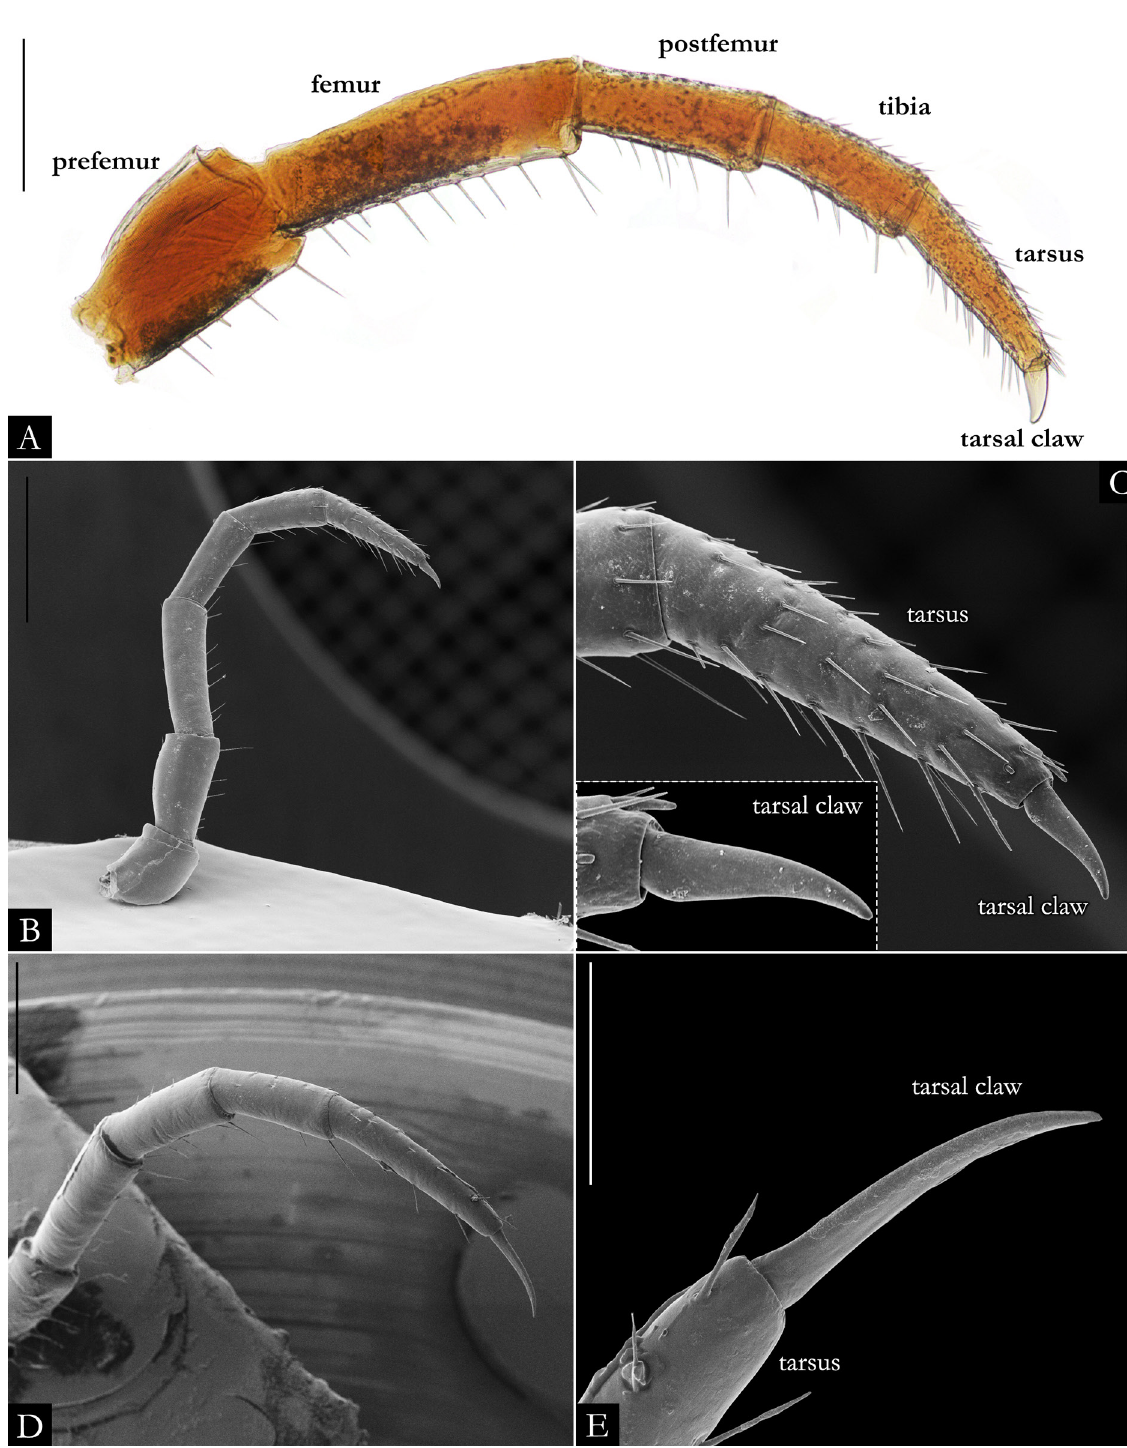
Fig. 29. Microscope and SEM images of midbody legs. A . Pseudonannolene microzoporus Mauriès, 1987 (IBSP 3497). B–C . P. robsoni Iniesta & Ferreira, 2014 (IBSP 3526). D–E . P. strinatii Mauriès, 1974 (IBSP 7633). Scale bars: A, D = 0.5 mm; B = 1 mm; C = 0.3 mm; E = 0.2